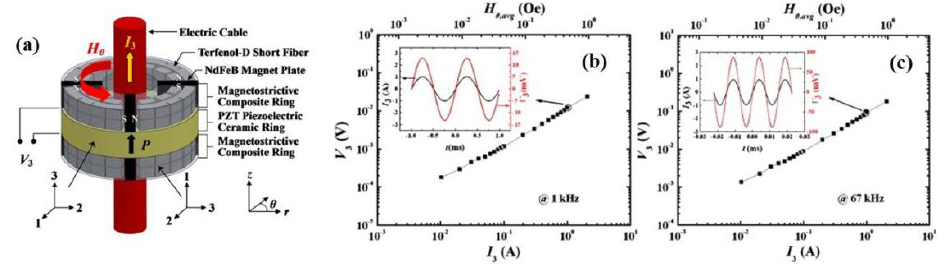
Figure 11. ( a ) Schematic diagram of the proposed ring-type electric current sensor. ( b ) and ( c ) The AC electric voltage (V 3 ) output from the sensor as a function of both the AC electric current (I 3 ) and its associated average AC vortex magnetic field (H θ,avg ) [90].